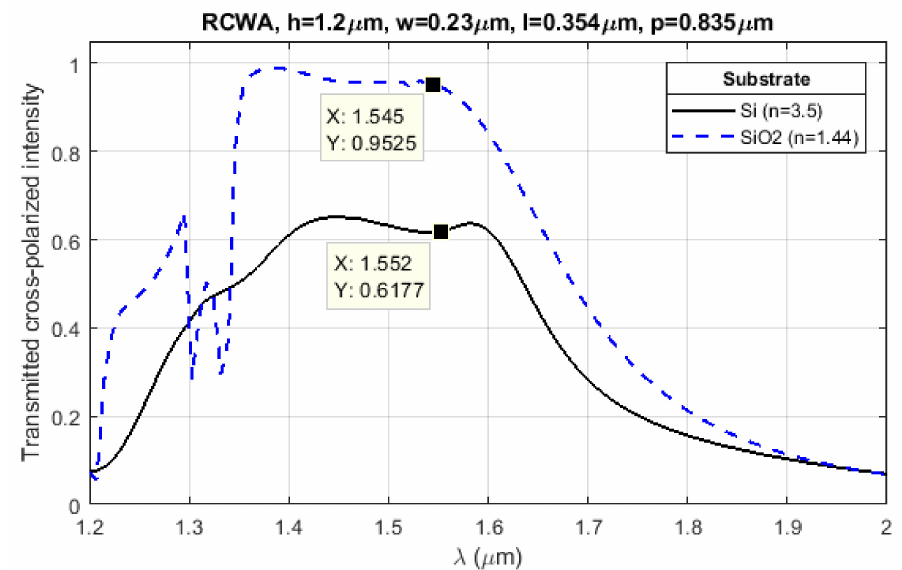
Figure 2. Rigorously coupled wave analysis (RCWA) simulations of rectangular silicon pillars on two different substrate materials: silicon and silicon dioxide (e.g., a quartz or fused silica wafer). The difference in efficiency is largely explained by differences in transmissivity from the substrate to air due to their differences in refractive index: 3.5 for Si and 1.44 for SiO 2 for